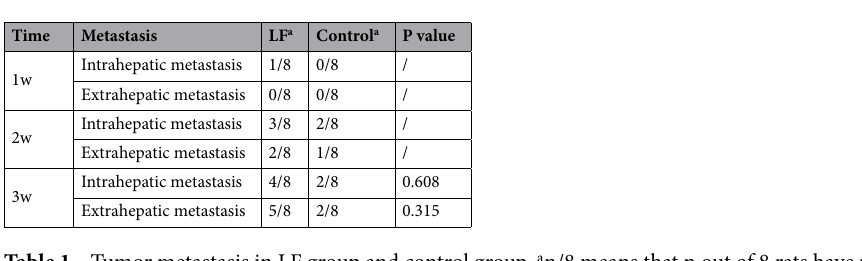
Table 1. Tumor metastasis in LF group and control group. a n/8 means that n out of 8 rats have metastasized at the given